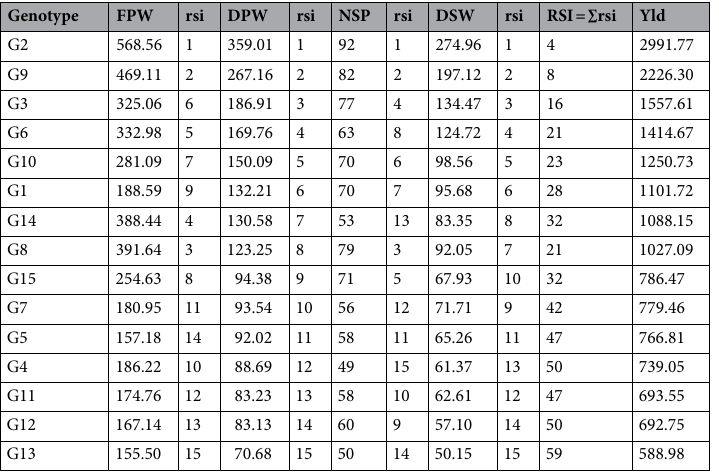
Table 10. Mean value of positive, strongly significant correlated traits with yield and their rank summation index (RSI). FPW (g) fresh pod weight, DPW (g) dry pod weight, NSP no. of seed per plant, DSW (g) dry seed weight, Yld (kg/ha) yield, RSI Rank summation